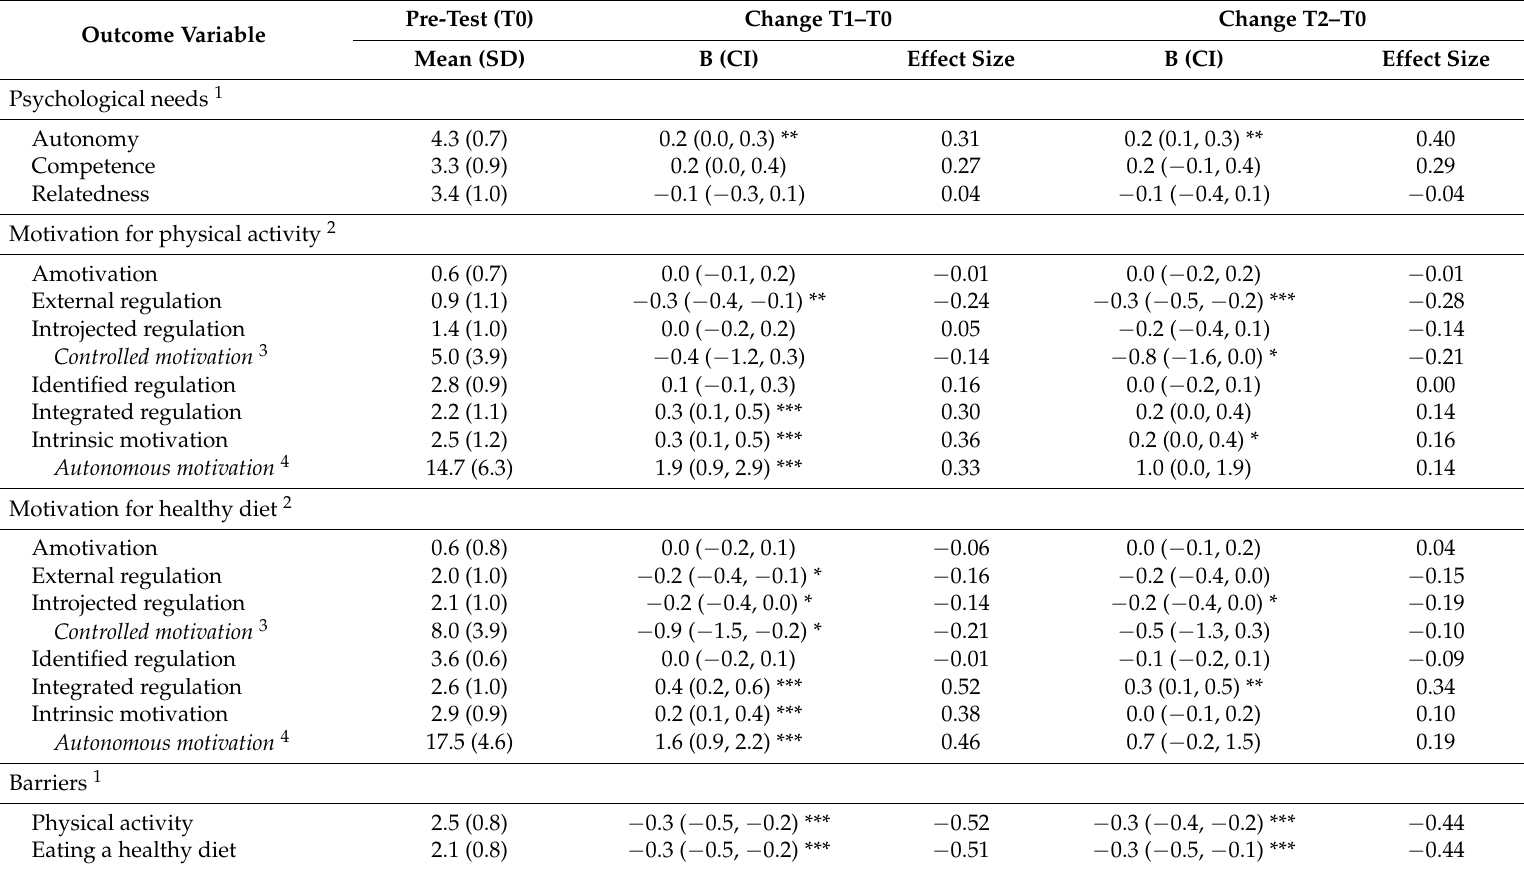
Table 2. Average changes among adults regarding psychological needs, motivation for physical activity and healthy diet, barriers, physical activity, dietary behaviour, quality of life and body mass index (BMI), at T1 and T2 compared to T0, analysed using linear mixed